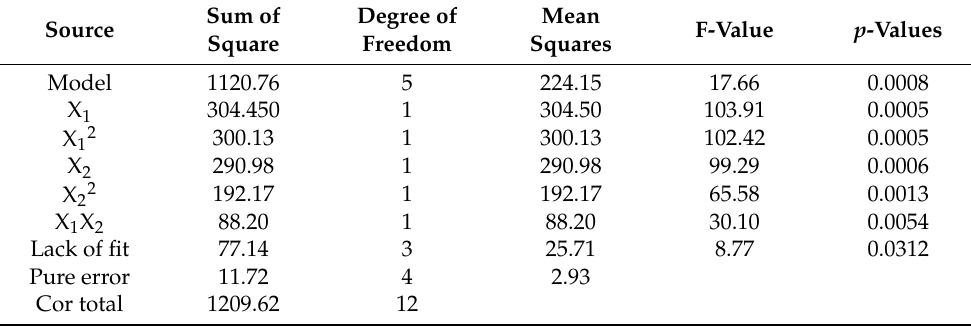
Table 8. Variance analysis of regression equation Y 1.